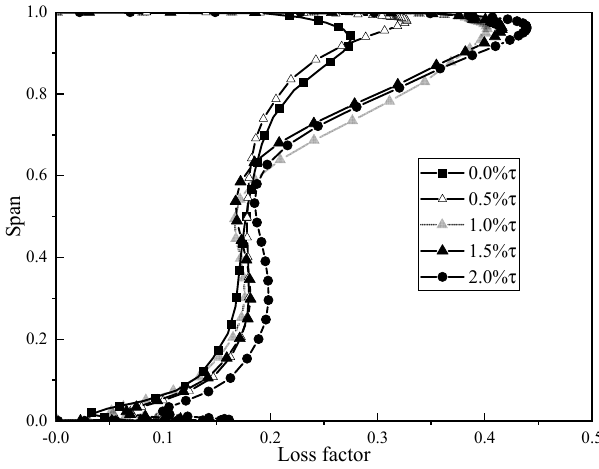
Figure 7. Loss factor distribution under different clearance models.